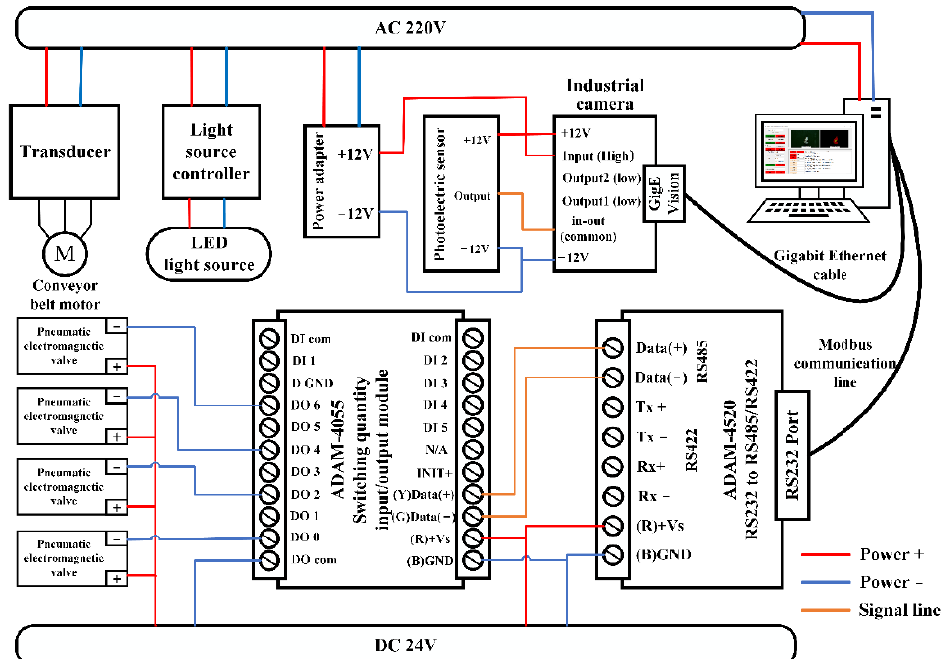
Figure 10. Schematic diagram of the system